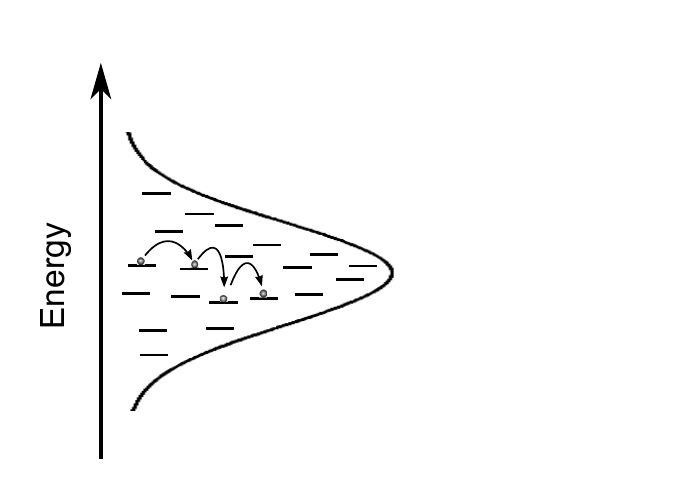
Figure 2. Exciton hopping in the intrinsic DOS which is approximated by a Gaussian distribution.